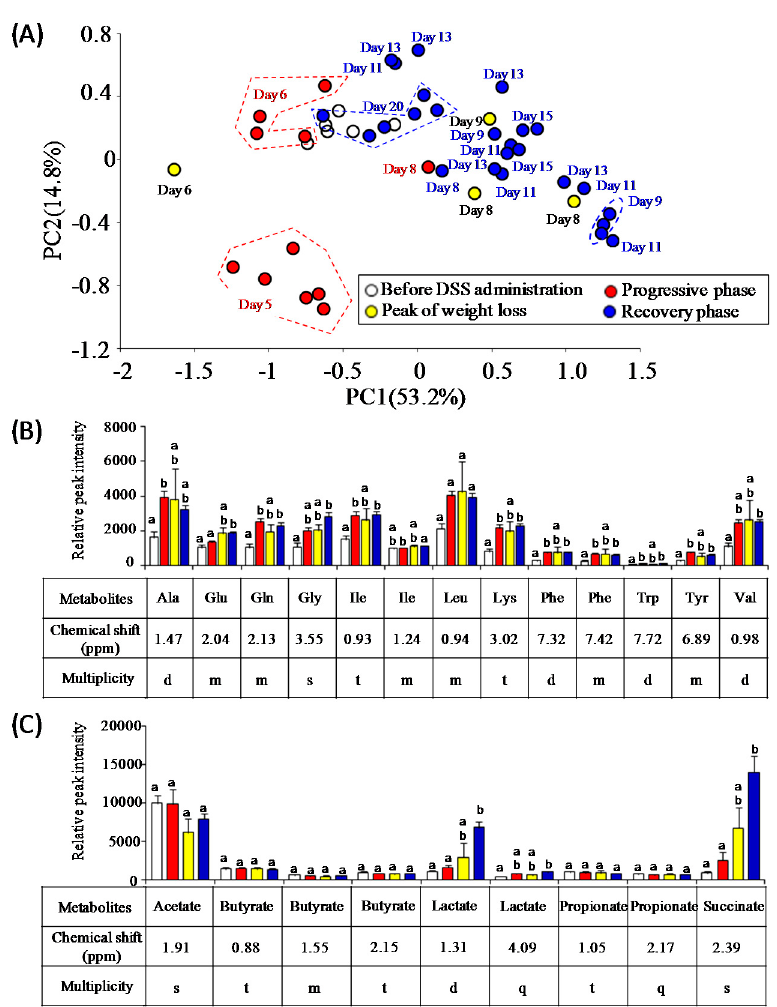
Figure 4. Characteristics of changes in fecal metabolites of DSS-treated mice. ( A ) Principal component analysis (PCA) score plots of fecal metabolites at each time point; ( B ) Changes in relative peak intensities of amino acids; ( C ) Changes in relative peak intensities of short chain fatty acids and organic acids. Different letters indicate significant differences between bars.